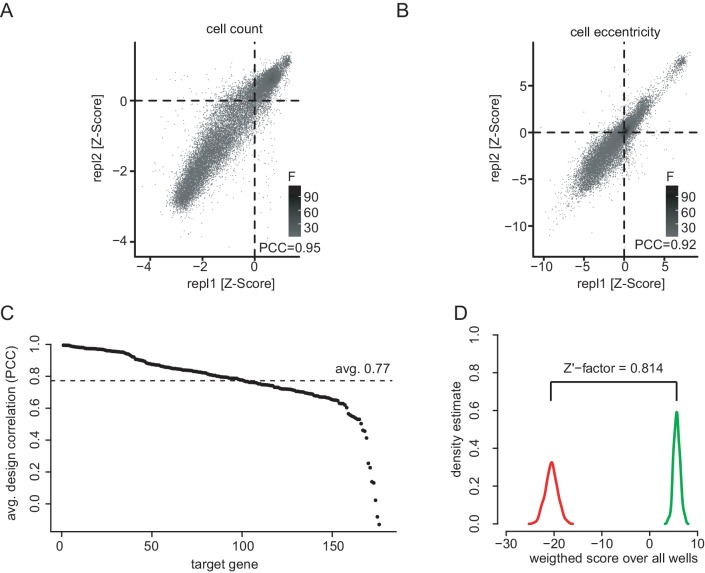
Screening quality control.(A) Quality control of the co-RNAi screen. Scatter plots showing all replicate measurements of normalized and processed phenotypic feature data for cell count (PCC = 0.95) and cell eccentricity (B, PCC = 0.92). Plates for which positive (RasGAP1) and negative (Diap1) controls could not be distinguished (Z’-factor < 0.3) were excluded. Data was normalized for plate and batch effects using median normalization and scaled and centered using Z-score analysis. (C) RNAi reagents ranked by dsRNA design correlation. dsRNAs were paired by gene to calculate pairwise correlations along 16 selected features. All dsRNAs together showed an average design correlation of PCC = 0.77. Figure C and D show data 96 hr after MEK inhibitor treatment representatively. (D) Assay performance assessed by statistical effect size. The multi-variate Z’-factors between the positive control knockdown of RasGAP1 and a negative control knockdown of Pvr (Zhang et al., 1999) were calculated for the selected 16 phenotypic features for the MEKi screen after 96 hr.